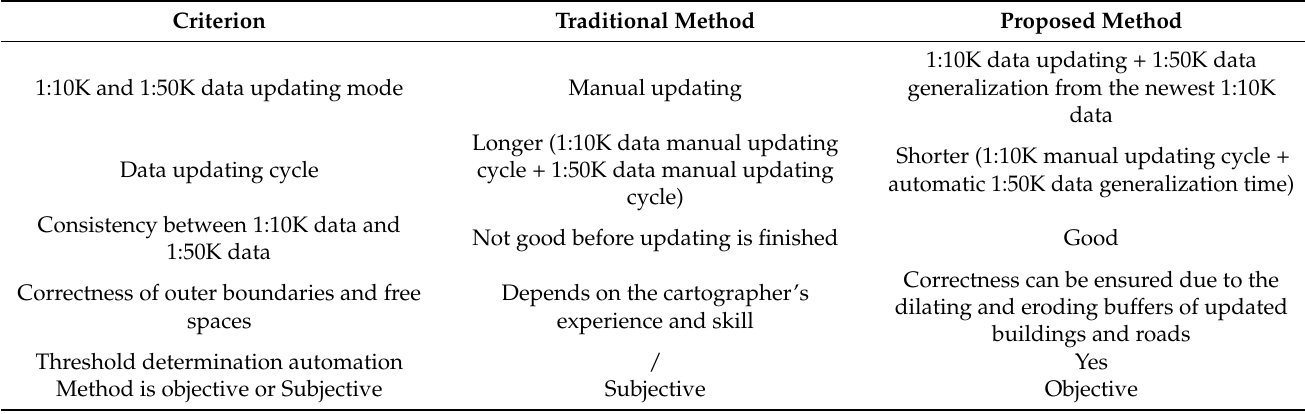
Table 5. Satisfaction of requirements for ideal data generalization